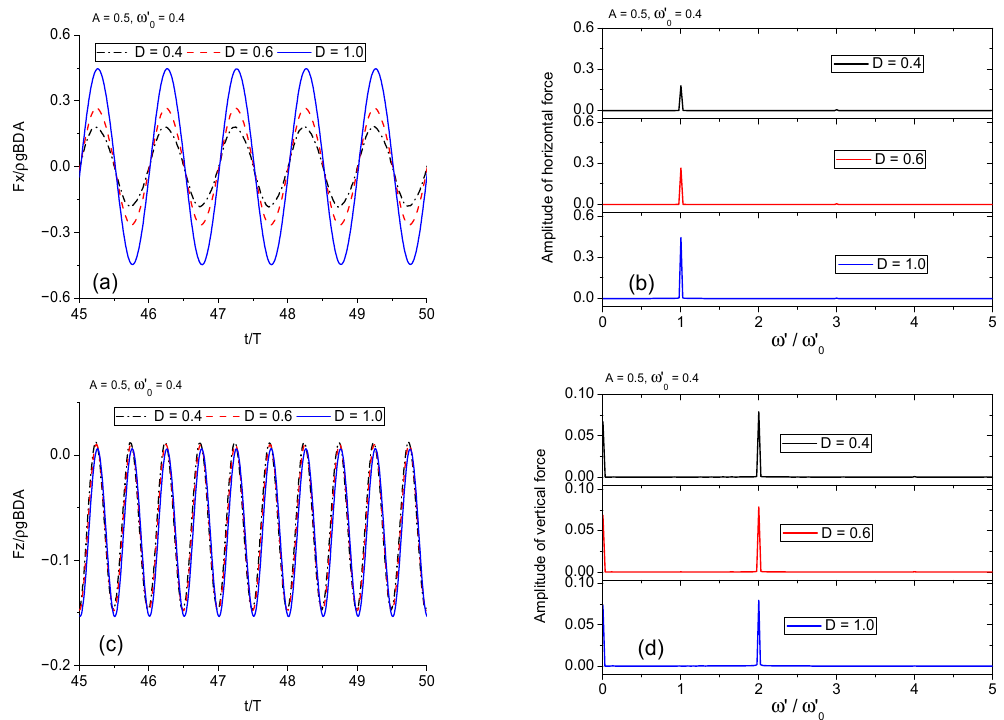
Figure 11. Normalized force histories of di ff erent draughts and their FFT analysis when A = 0.5, ω (cid:48) = 0.4: ( a ) horizontal force histories; ( b ) FFT analysis of horizontal forces; ( c ) vertical force histories; ( d ) FFT analysis of vertical forces.